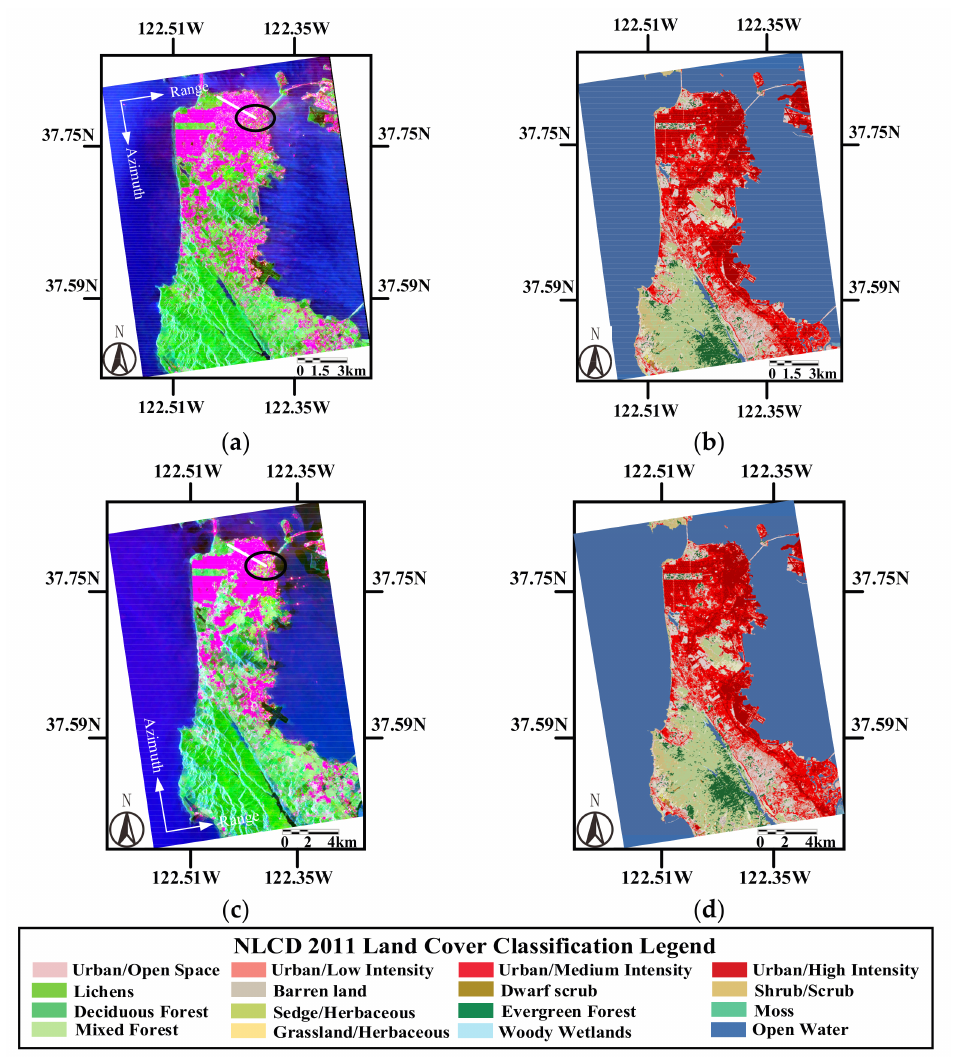
Figure 12. Proposed decomposition results (blue-surface scattering, red-urban scattering, and green-volume scattering) and ground references for spaceborne data: ( a , b ) Radarsat-2 C-band data; and ( c , d ) ALOS PALSAR L-band